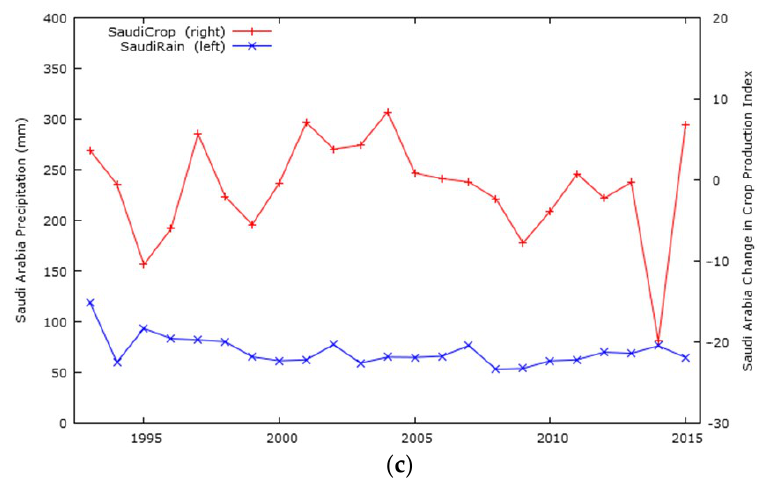
Figure 3. ( a ) Annual precipitation and change in crop production index for Iran between 1993 and 2015 [18,19]; ( b ) Annual precipitation and change in crop production index for Iraq between 1993 and 2015 [18,19]; ( c ) Annual precipitation and change in crop production index for Saudi Arabia between 1993 and 2015 [18,19].